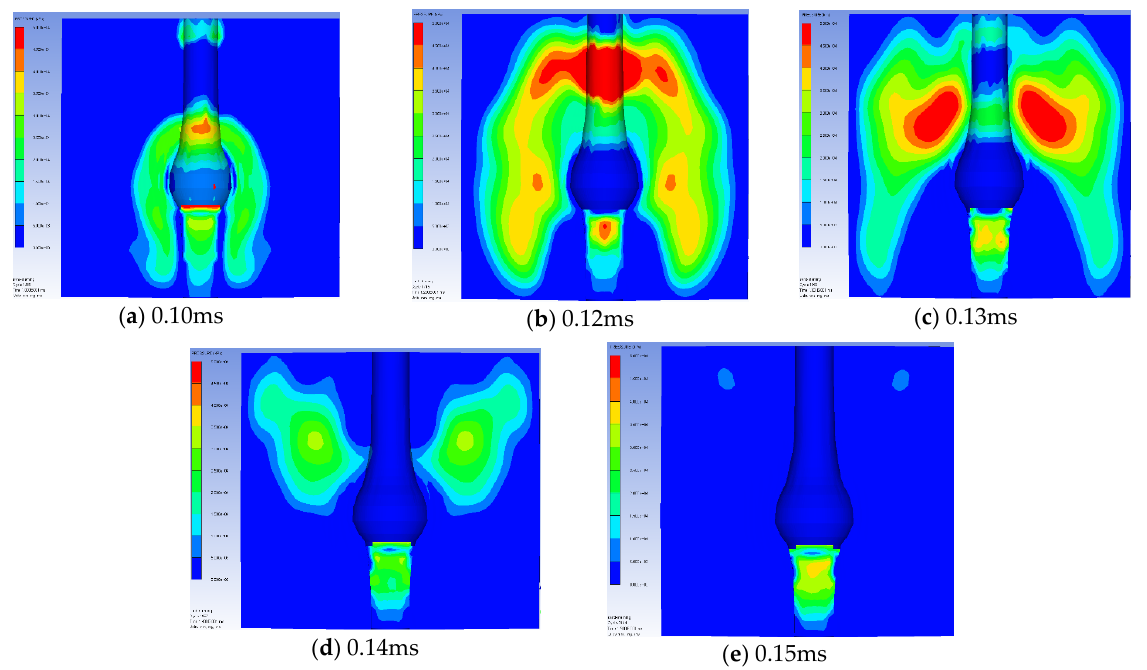
Figure 15. Blast hole expansion of the lead block according to different stemming materials.